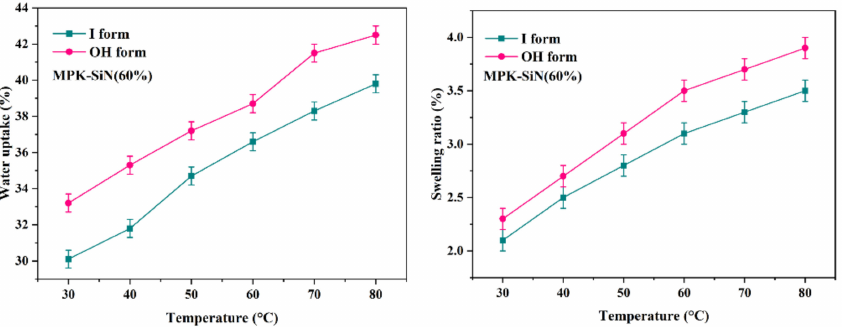
Figure 3. Temperature dependence of water uptake and swelling ratio of MPK–SiN (60%).